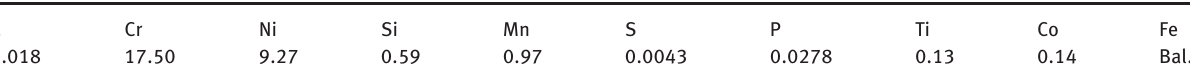
Table 1: Chemical compositions of 1Cr18Ni9 stainless steel (wt%)